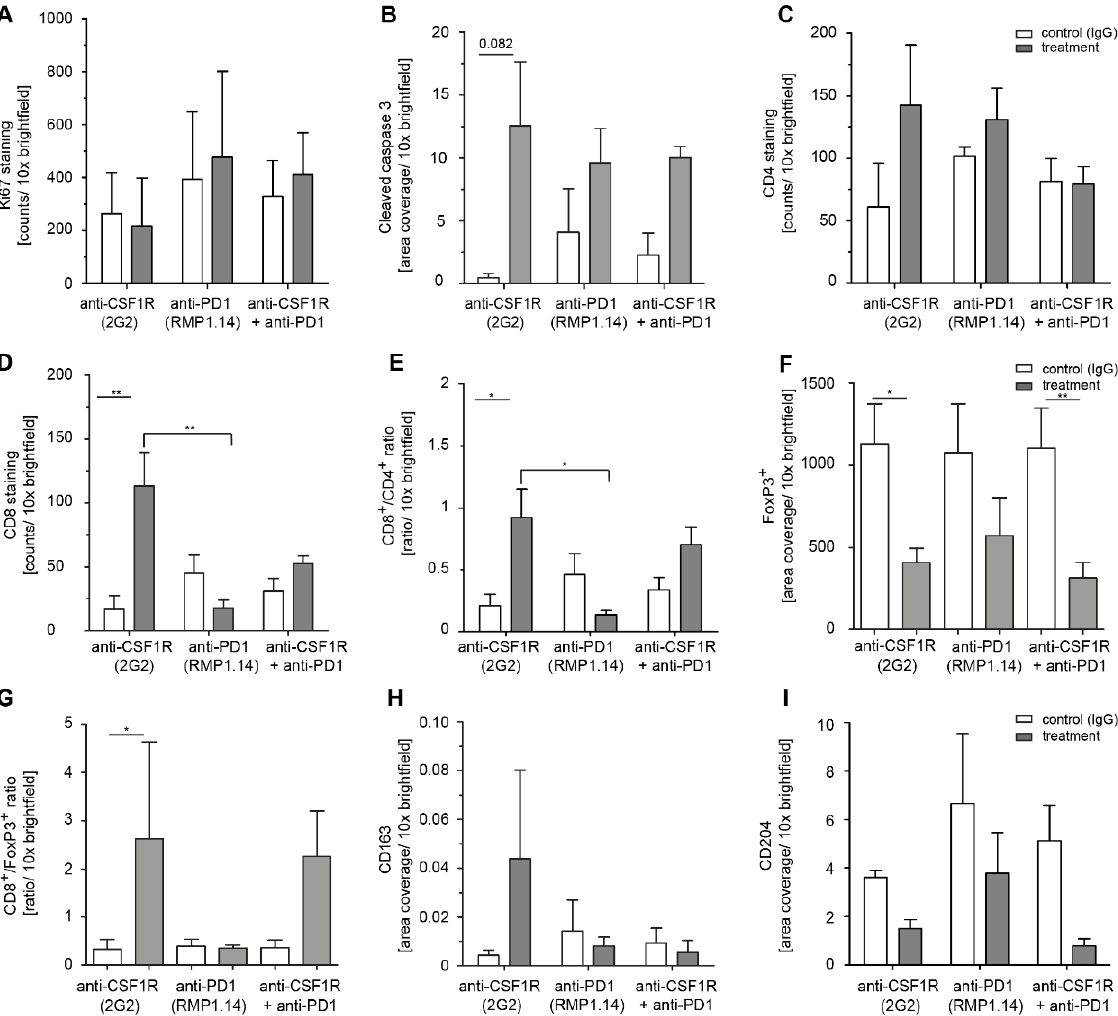
Figure 5. Quantification of Ki67, cleaved caspase 3, CD4, CD8 as well as CD8/CD4, and CD8/FoxP3 ratios in post-treatment tissue. Quantification of Ki67 ( A ), cleaved caspase 3 ( B ), CD4 ( C ), CD8 + ( D) , CD8 + /CD4 + ratio ( E ), FoxP3 + ( F ), CD8/FoxP3 ratio ( G ), CD163 ( H), and CD204 ( I ) in tumor tissues after 2 injections of CSF1R and 3 injections of PD1 antibodies. Three animals (n = 3) in each group were analysed. Statistical analysis was done using one-way ANOVA followed by Tukey’s multiple comparison test. ** p < 0.01, * p < 0.05.